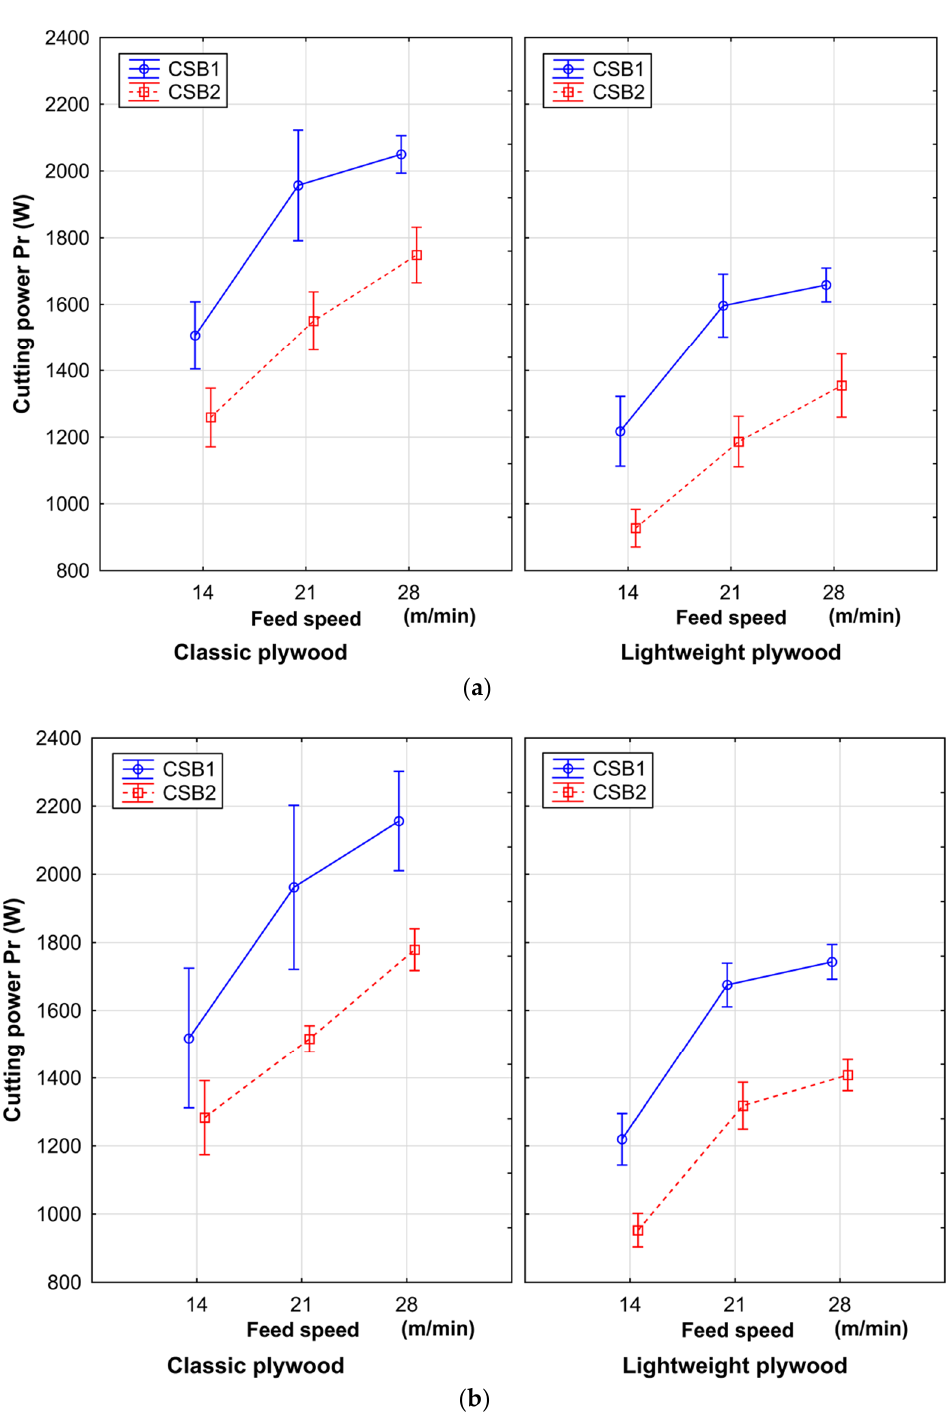
Figure 7. Cutting power depending on feed speed and type of circular saw blade (CSB) in sawing classic and lightweight plywood: ( a ) rotation speed = 4050 min −1 ; ( b ) rotation speed = 4150 min −1 .